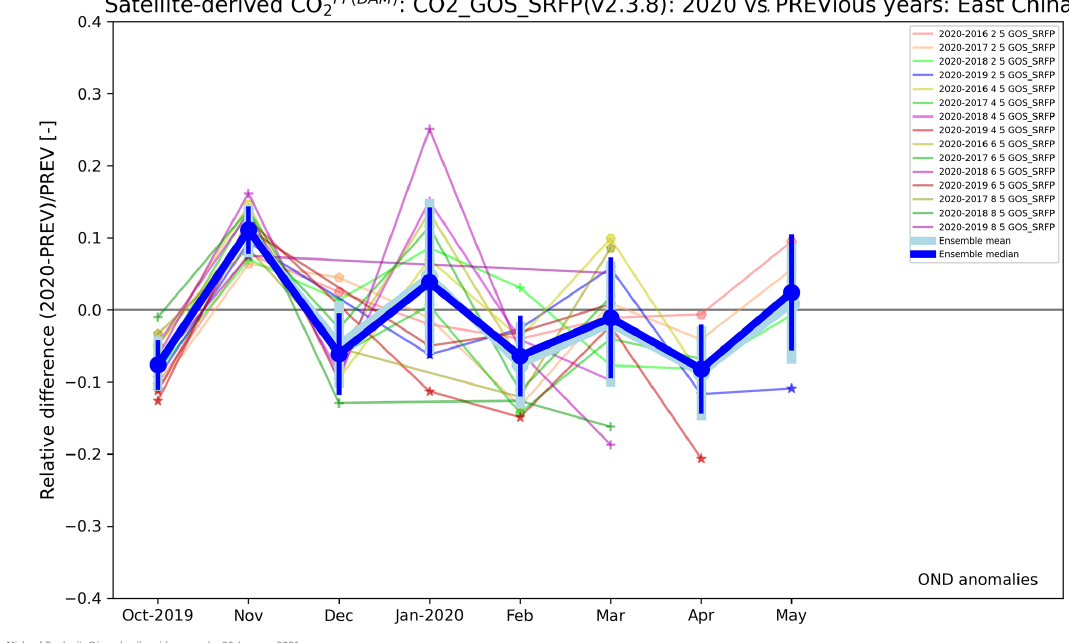
Figure 11. The same as Fig. 10 but for the product